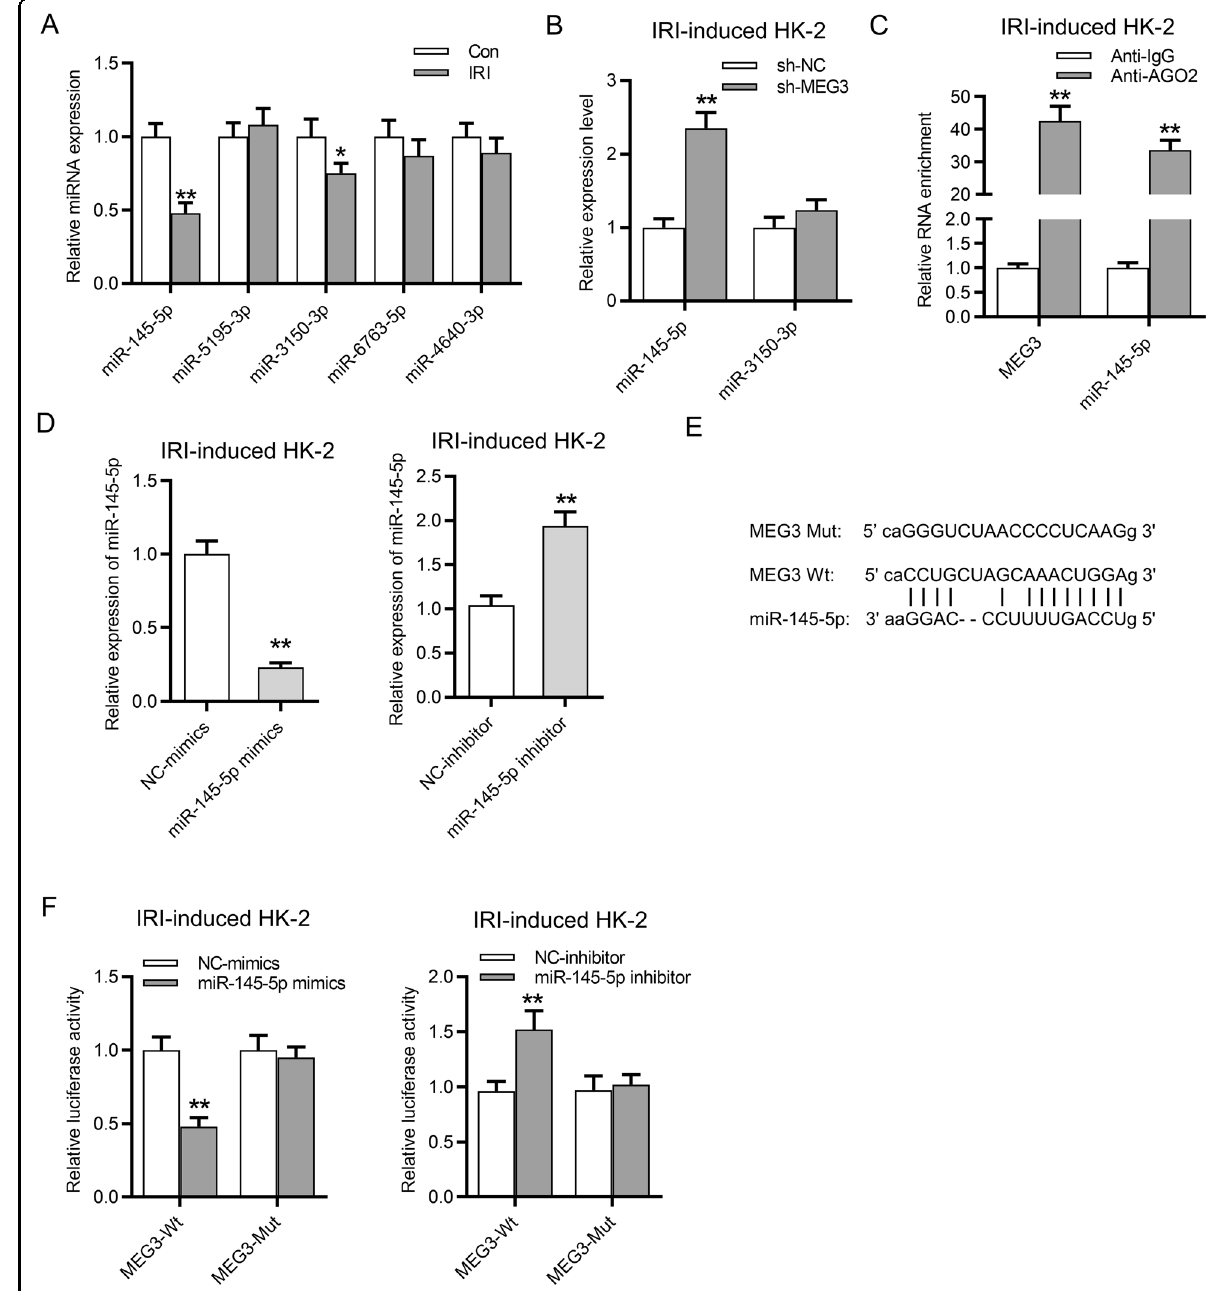
Fig. 4 MEG3 can bind with miR-145-5p in HK-2 cells following IRI. A RT-qPCR evaluated the expression of fi ve candidate miRNAs in HK-2 cells following IRI. B RT-qPCR identi fi ed the expression of miR-145-5p and miR-3150-3p in IR-treated HK-2 cells after transfection of sh-MEG3. C RIP assay was conducted to determine the relative enrichment of MEG3 and miR-145-5p in precipitations of anti-IgG and anti-Ago2 in HK-2 cells following IRI. D RT-qPCR revealed the overexpression and knockdown ef fi ciency of miR-145-5p in HK-2 cells following IRI. E The binding site of MEG3 and